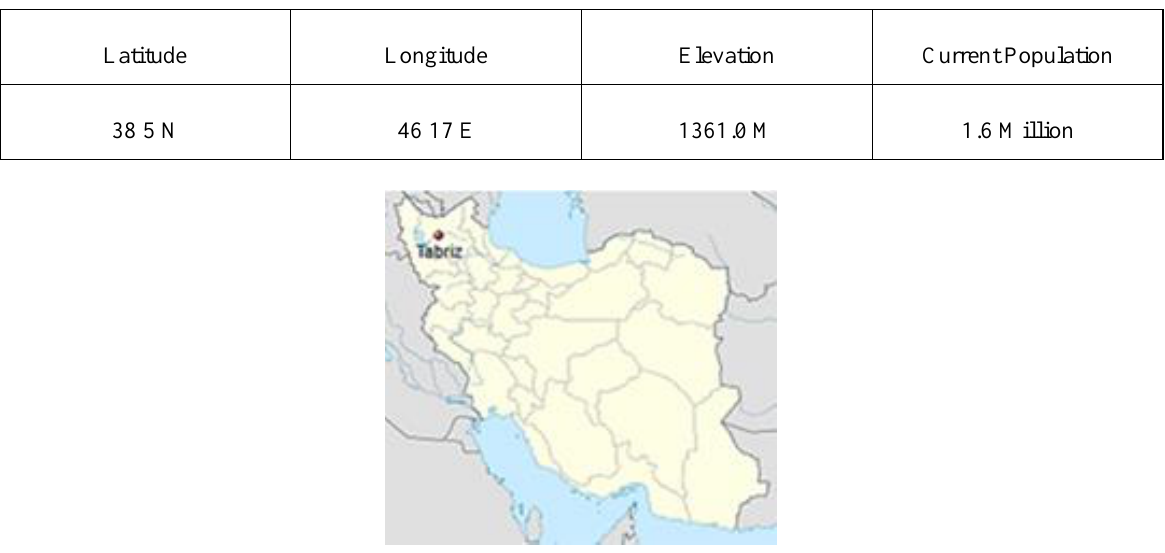
Table 1. General geographical information of Tabriz (Source: Iran Meteorological Organization, 2018; Encyclopedia Britannica,